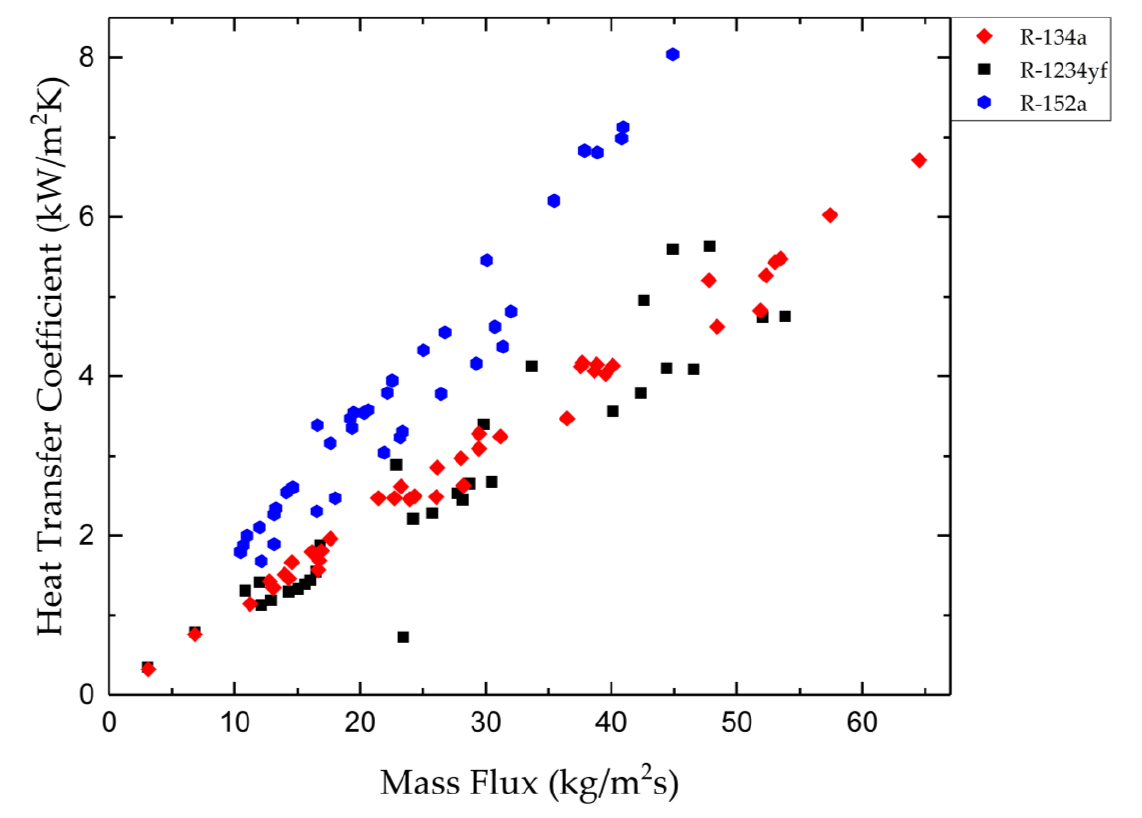
Figure 10. Experimental HTCs for R-152a, R-1234yf, and R-134a versus the mass flux [53]. Table 3. Inside the tube, specifications, dimensions, and experimental conditions from the